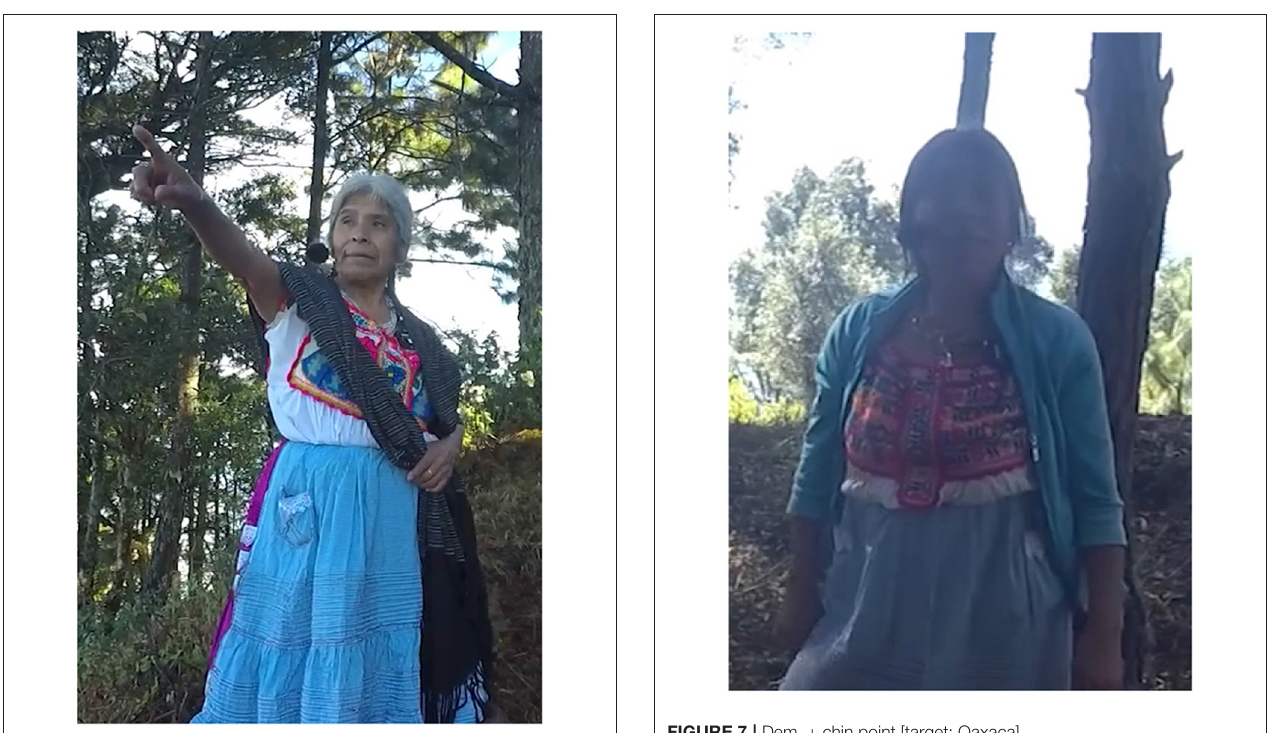
FIGURE 6 | State scale [target: Rio Grande].